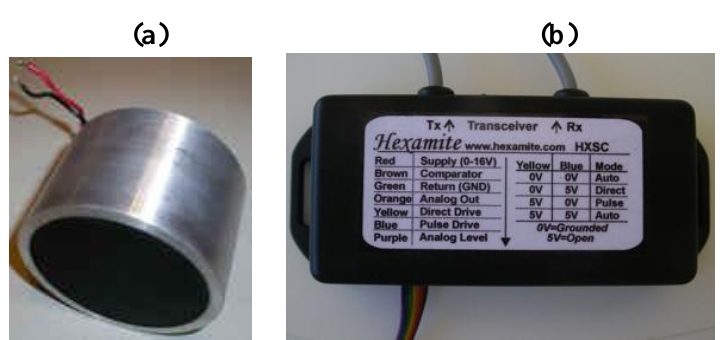
Figure 3. (a) Ultrasonic sensor. (b) Signal